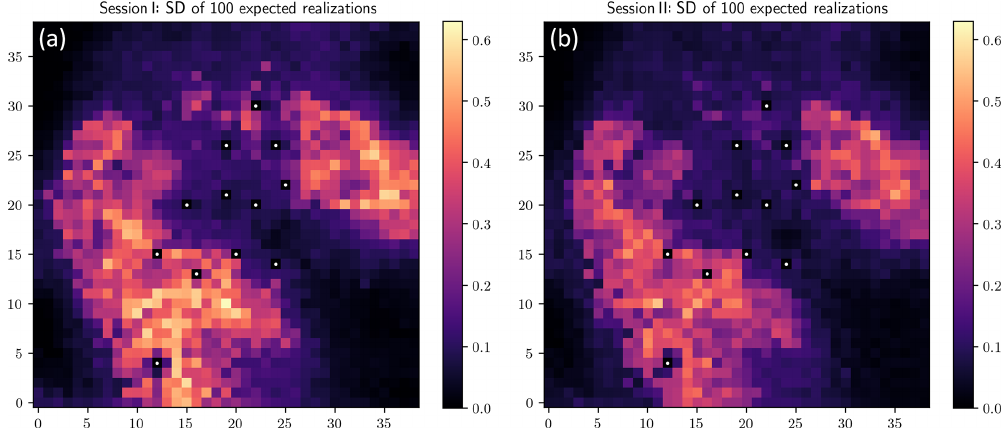
Figure 10. Standard deviation of 100 expected realizations (mm) from Session I (a) and Session II (b) .